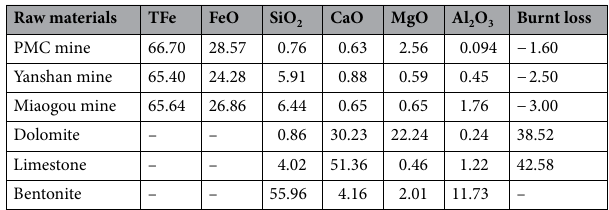
Table 1. Chemical compositions of experimental raw materials (wt%).